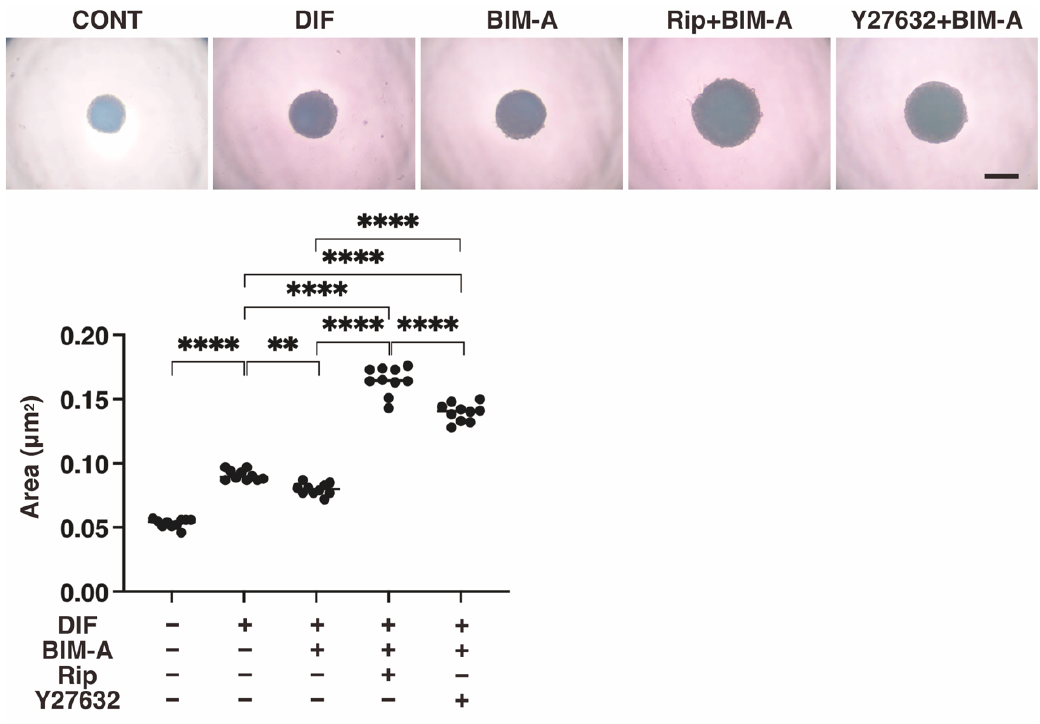
Figure 5. Additional effects of ROCK-i on BIM-A on the mean area sizes of the 3T3-L1 3D spheroids. The 3D spheroids of 3T3-L1 cells were cultured under several conditions: preadipocytes of 3T3-L1 cells (CONT) or their adipogenic differentiation (DIF) with or without the combination of 100 nM BIM-A (BIM-A) and ROCK-i (10 μ M Ripasudil (Rip) or 10 μ M Y27632). The mean area sizes ( μ m 2 ) of the spheroids were measured and compared among experimental groups on Day 7. All